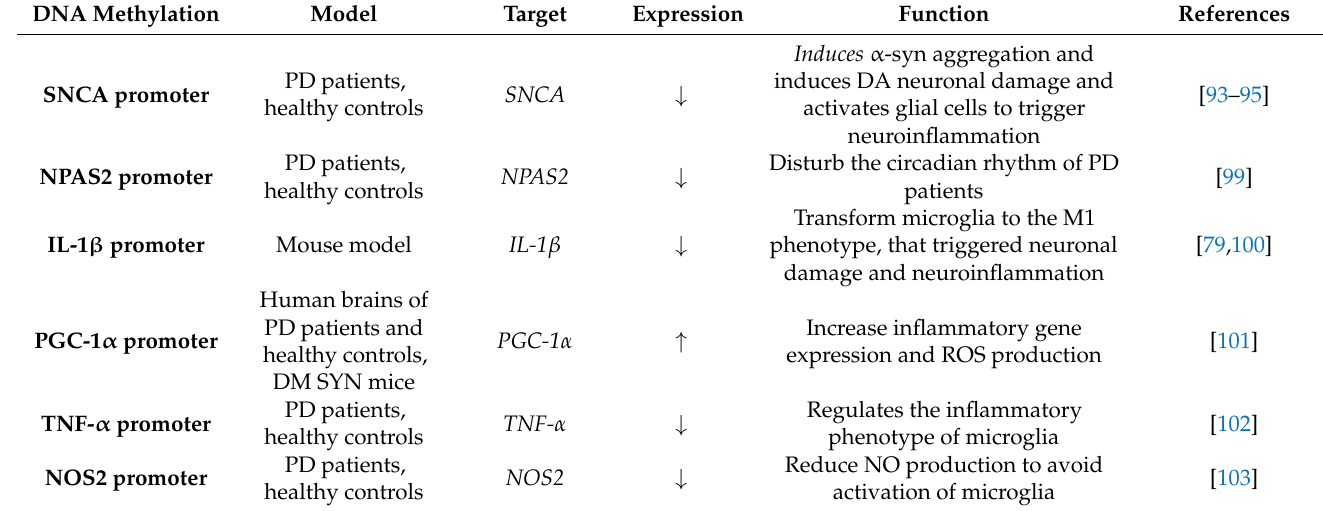
Table 4. DNA methylation involved in the neuroinflammation in Parkinson’s disease. ↑ shows up-regulated and ↓ shows down-regulated. DNA Methylation Model Target